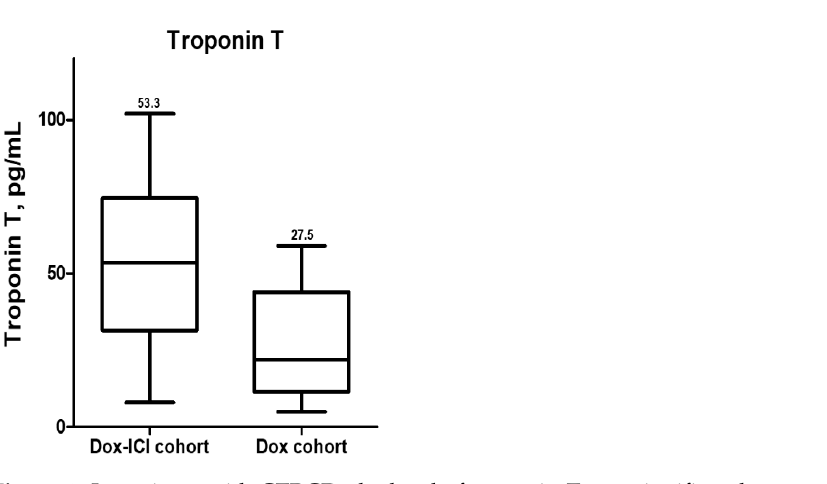
Figure 4. In patients with CTRCD, the level of troponin-T was significantly more elevated in the Dox-ICI cohort than in the Dox